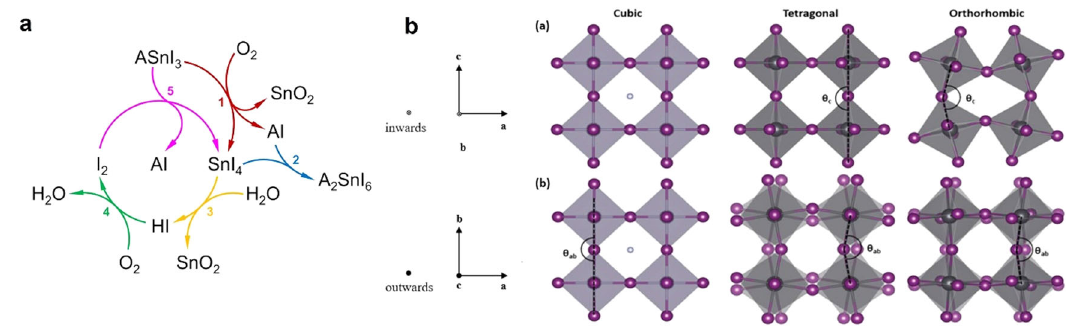
Fig. 6 Impact of the environmental factor impact on Sn-HPs. a Proposed cyclic degradation mechanism of tin-based perovskites under O 2 and H 2 O b Cubic- α , tetragonal- β , and orthorhombic- γ structure of black-photoactive phases (Fig. 6a reprinted with permission from ref. 14 , Copyright 2021 Springer Nature. Fig 6b reprinted with permission from ref. 47 , Copyright 2021